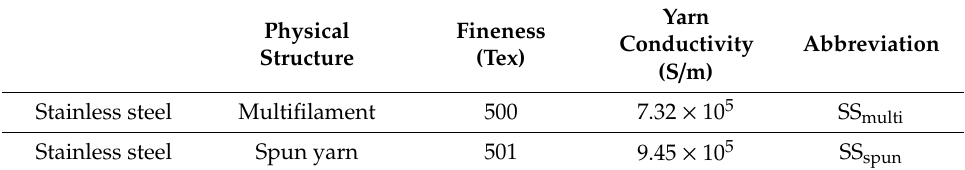
Table 2. Summary of the di ff erent 100% stainless steel yarns.